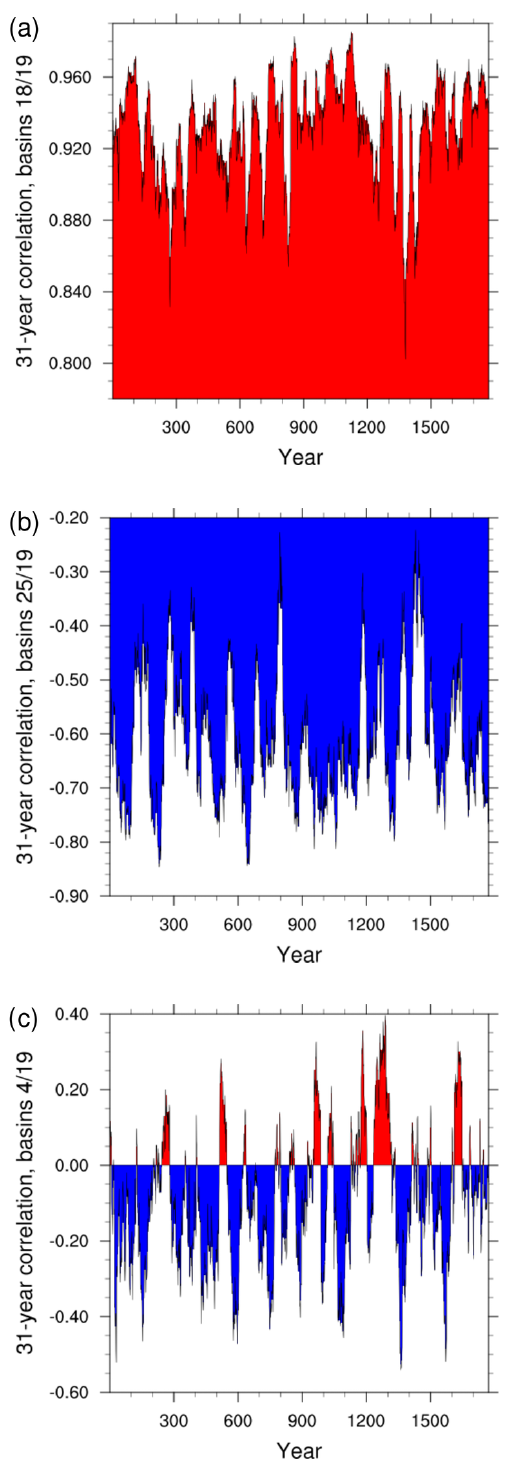
Figure 7. Evolving inter-basin correlations between basin 19 and basins 18, 25 and 4. Correlation time series constructed using a moving 31-year window. Red/blue: positive/negative inter-basin correlation